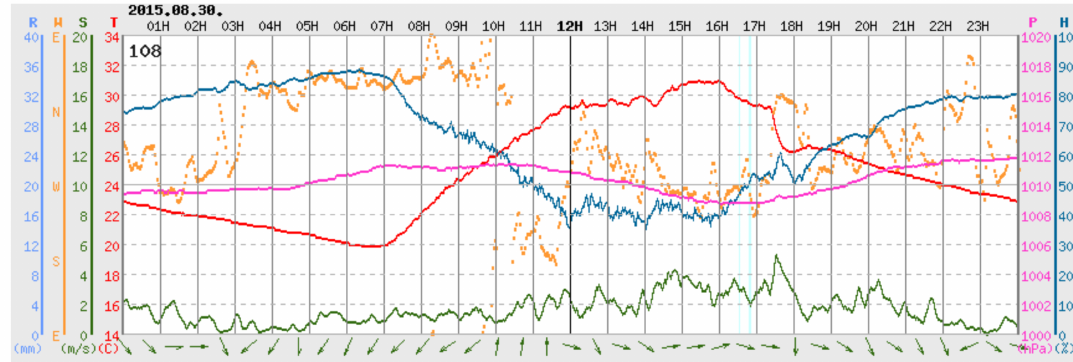
Figure 6. Time series of meteorological variables from Korea Meteorological Administration (KMA) Automated Weather Station (AWS) number 108 (Seoul weather station, SWS) for the entire day [local time] of 30 August 2015: Temperature (red line, [ ◦ C]), pressure (pink line, [hPa]), wind direction (orange dots, degrees), wind speed (green lines and green wind vectors at the bottom of the figure), and relative humidity (blue line, [%]) at the surface. Data source: www.kma.go.kr (Korea Meteorological